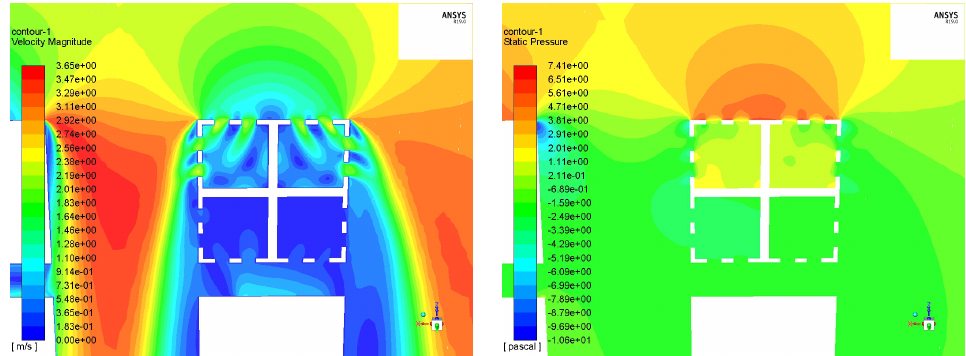
Figure 2. Wind-driven air flows inside and around buildings: velocity ( on the left ) and pressure ( on the right ) contour